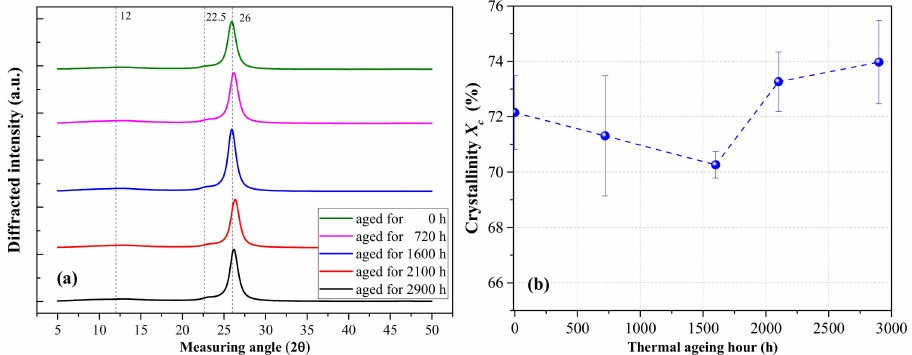
Figure 2. ( a ) X-ray di ff raction (XRD) curves and ( b ) calculated crystallinity X c of thermally aged PET films aged at 110 ◦